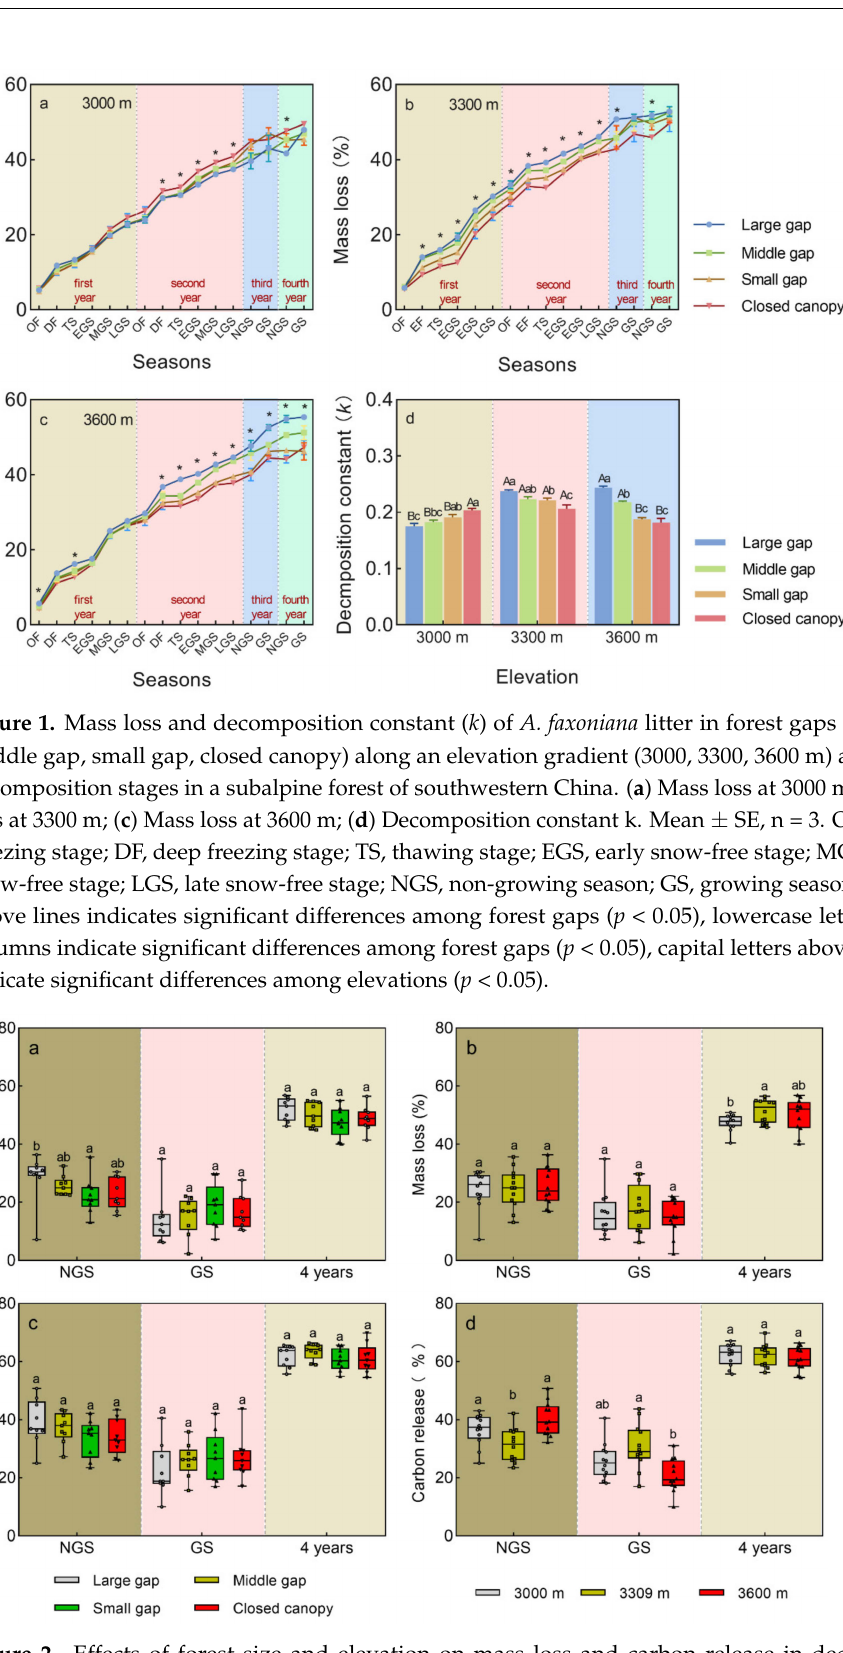
Figure 2. Effects of forest size and elevation on mass loss and carbon release in decomposing A. faxoniana litter. ( a ) Mass loss on forest gap scale; ( b ) Mass loss on elevation scale; ( c ) Carbon release on forest gap scale; ( d ) Carbon release on elevation scale. Mean ± SE, n = 3. NGS, the non-growing seasons in the four decomposing years; GS, the growing seasons in the four decomposing years. Lowercase letters indicate significant differences among forest gaps or elevations ( p <